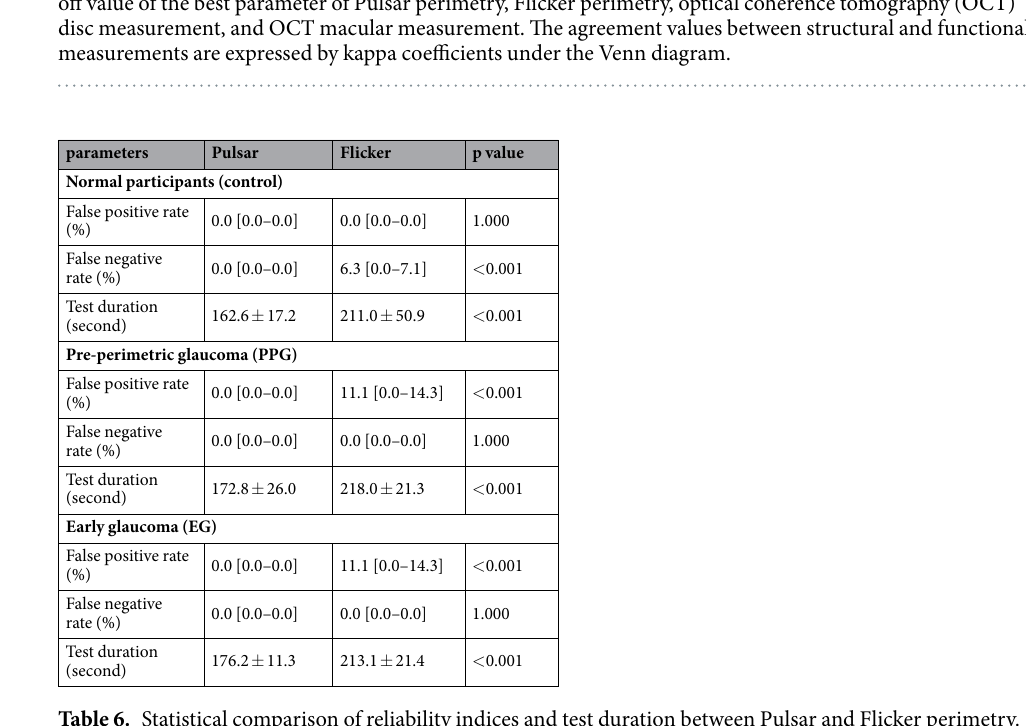
Table 6. Statistical comparison of reliability indices and test duration between Pulsar and Flicker perimetry. False positive and negative are expressed as median value [interquartile range] and analyzed by Wilcoxon signed-rank test. Test duration are expressed as mean ± standard deviation and analyzed by paired